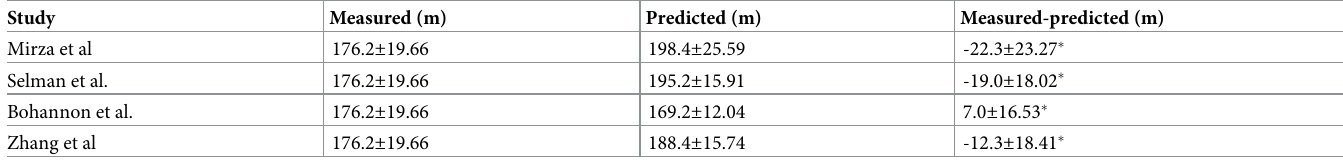
Table 5. Measured 2MWDs (m) and predicted 2MWDs (m) for the same age range based on the equations reported in previous studies. Study Selman et